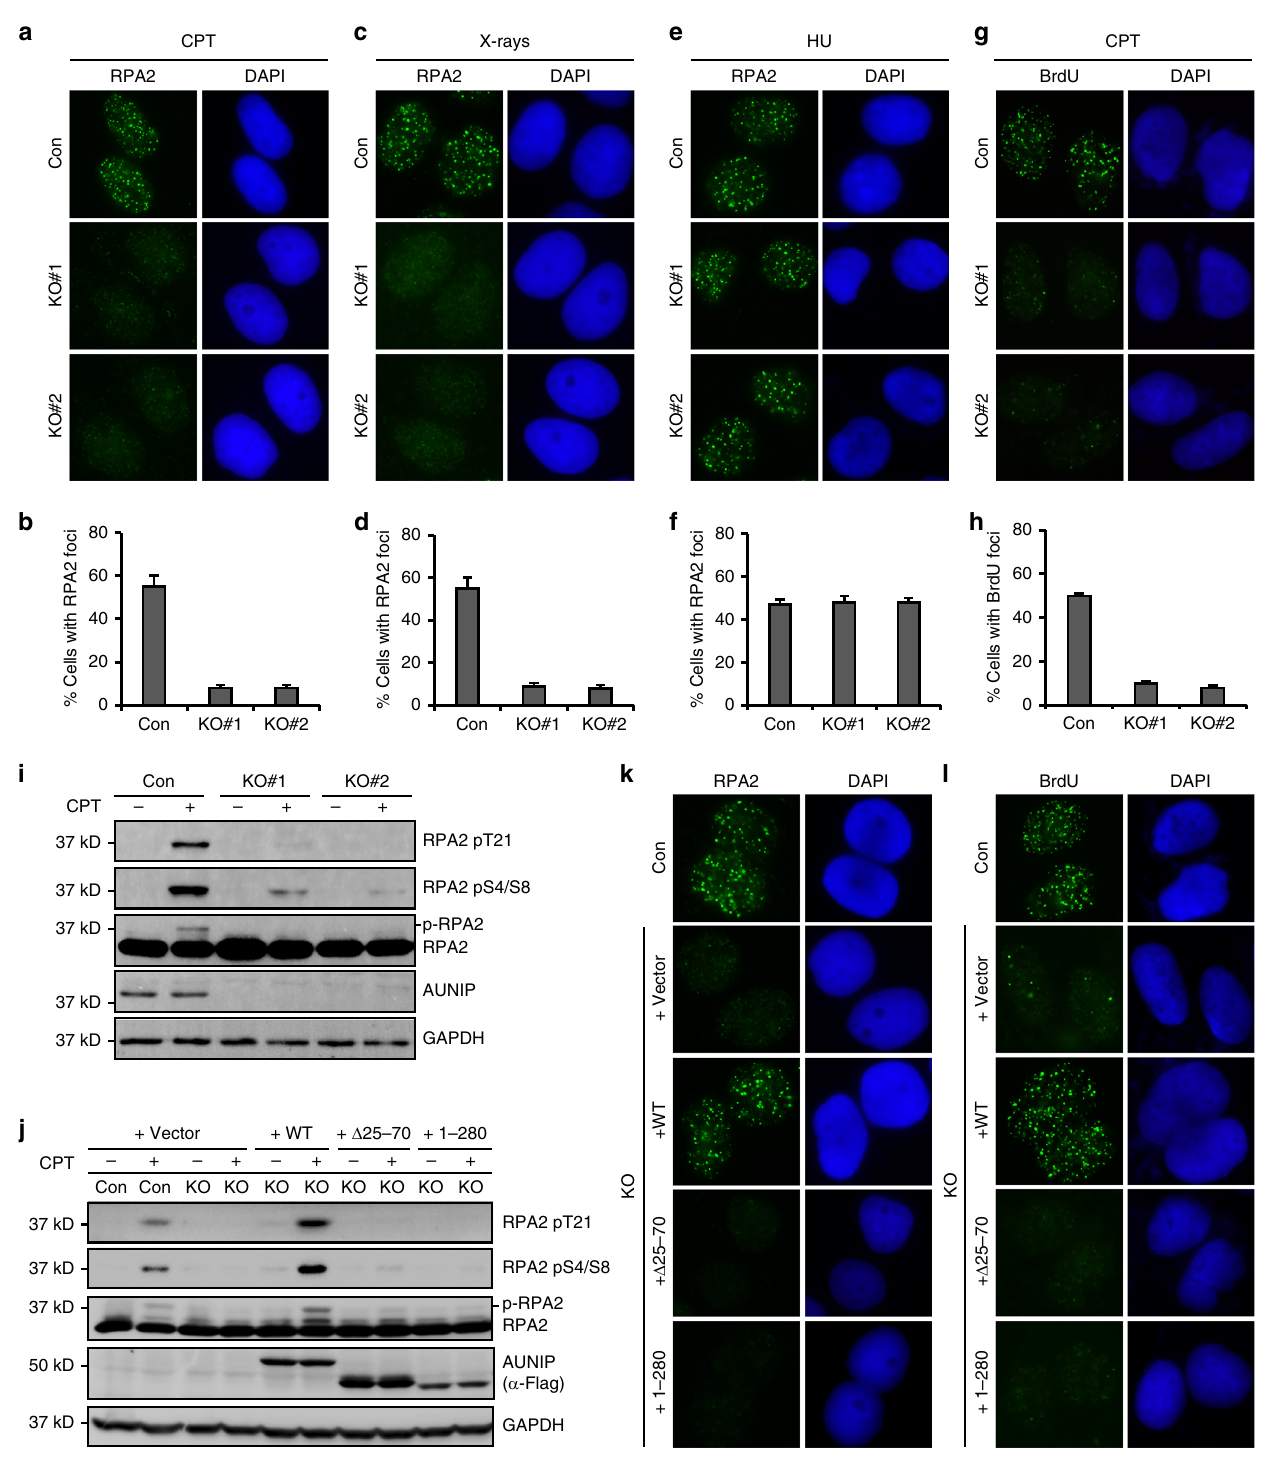
Fig. 4 AUNIP stimulates DNA end resection. a – d Knockout of AUNIP impairs CPT-or X-ray-induced RPA2 foci formation. AUNIP-de fi cient HeLa cells were treated with 1 μ M CPT or 10Gy X-rays and were processed for RPA2 immunostaining experiment 1h after. Representative RPA2 foci are shown in a , c . Data represent mean ± SEM from three independent experiments ( b , d ). e , f AUNIP does not affect HU-induced RPA2 foci formation. AUNIP-de fi cient HeLa cells were treated with 10mM HU for 1h before being processed for immuno fl uorescence studies using anti-RPA2 antibody. Representative RPA2 foci are shown in e . Data represent mean ± SEM from three independent experiments f . ( g , h ) Knockout of AUNIP impairs ssDNA formation. Wild-type or AUNIP-de fi cient U2OS cells were labeled with BrdU for 24h, and were subsequently treated with 1 μ M CPT for 1h. Cells were then stained with anti-BrdU antibody under non-denaturing conditions. Representative BrdU foci are shown in g . Data represent mean ± SEM from three independent experiments ( h ). i Knockout of AUNIP impairs CPT- induced RPA2 phosphorylation. Cells were treated with 1 μ M CPT for 1h and were processed for western blot analysis. j – l The AUNIP mutants lacking the ability to either localize to DNA damage sites or to bind to CtIP failed to restore RPA2 phosphorylation and RPA2/BrdU foci formation in AUNIP-de fi cient cells. AUNIP- de fi cient cells stably expressing vector control (Vector), wild-type AUNIP, the Δ 25 – 70 mutant, or the 1 – 280 mutant were treated with 1 μ M CPT for 1h. Cells were subsequently processed for western blot analysis ( j ) or for indirect immuno fl uorescence studies using anti-RPA2 ( k ) or anti-BrdU antibody ( l